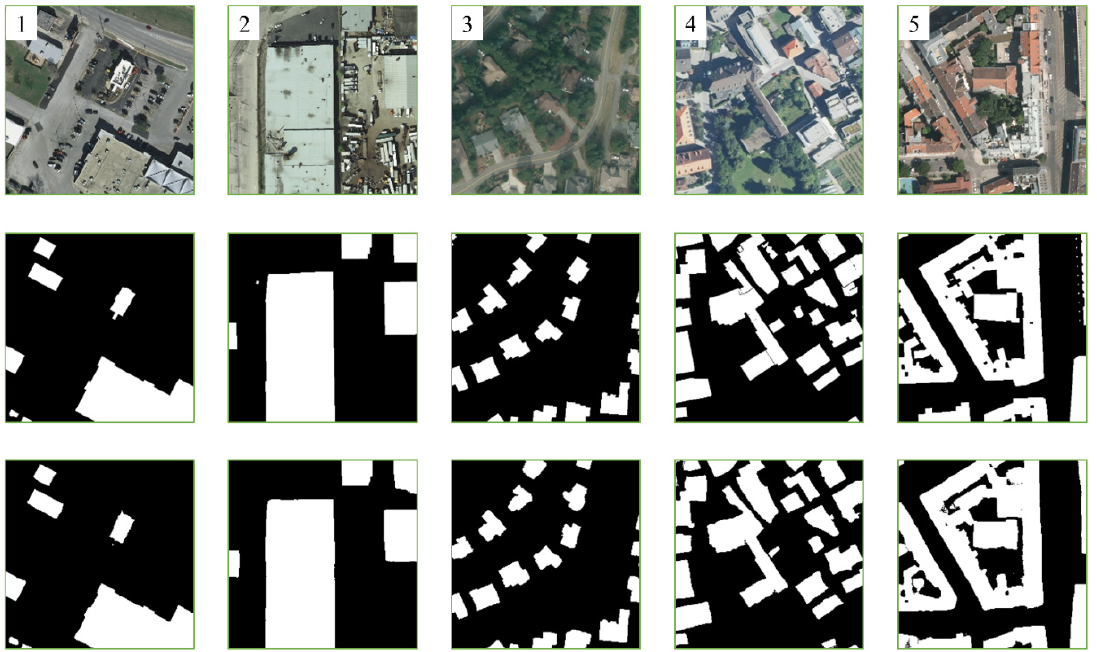
Figure 10. The extraction results of B-FGC-Net on the INRIA aerial image labeling dataset. The first to third rows are the test images, labels, and results, respectively. Numbers 1–5 represent Austin, Chicago, Kitsap County, West Tyrol, and Vienna, respectively.